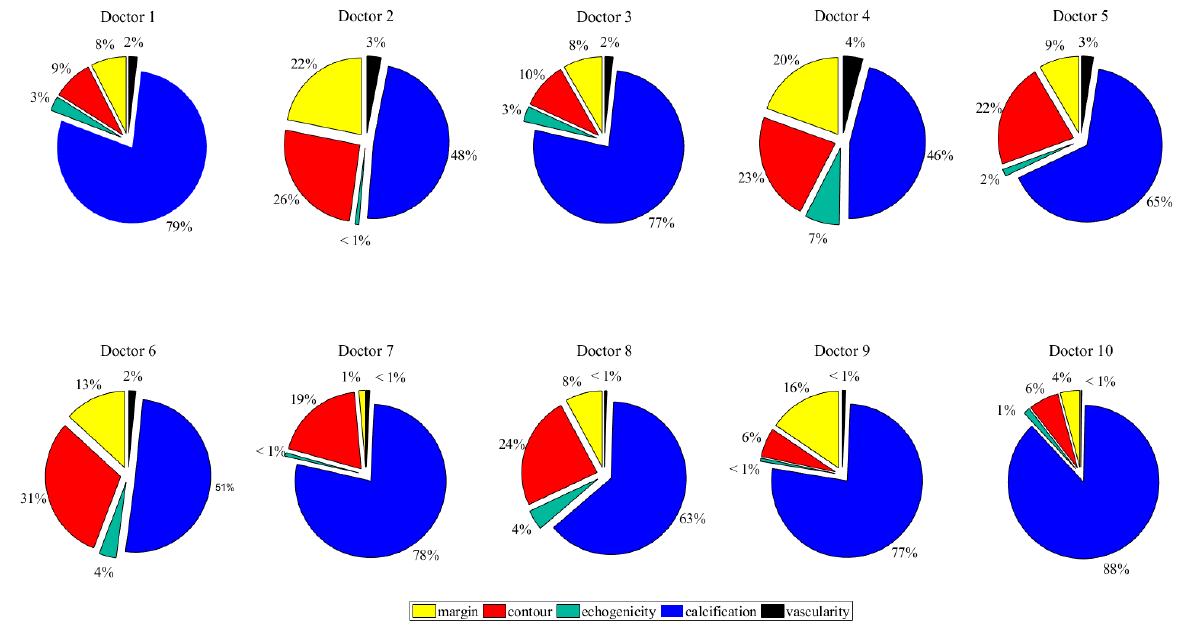
Figure 4. The percentage of criteria missing for each doctor.